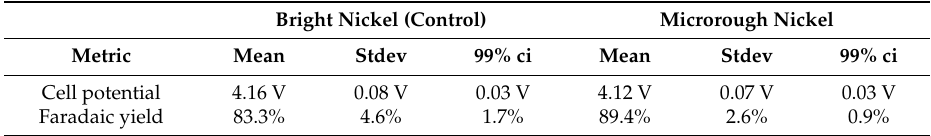
Figure 8. Library with Ni and Fe nanoparticles deposited using spark ablation. Nanoparticle (NP) deposition time is varied in the vertical direction (top is 1 s, bottom is 320 s), NP Ni / NP Fe ratio is varied in the horizontal direction (left is 100% Fe generator power, right is 100% Ni generator power). Top right shows a dark spot which was used to assess the deposition area. The spots underneath the dark spot visualize the e ff ect of an increasing deposition time. Table 1. Results of the alcohol oxidation experiments. (Stdev = standard deviation, ci = confidence interval).